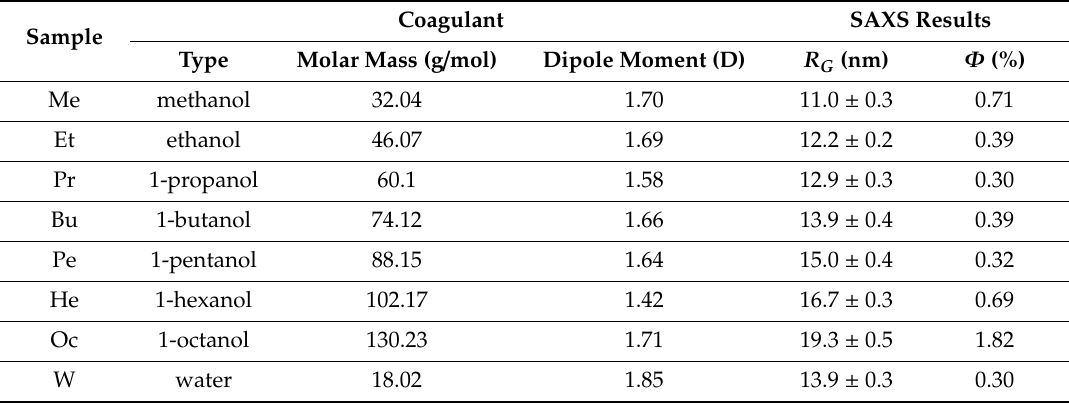
Table 2. Characteristics of the pure cellulose (CEL) membranes used for the study and values of structural parameters obtained by means of the SAXS method. R G : radius of gyration, Φ : volume fraction of pores.